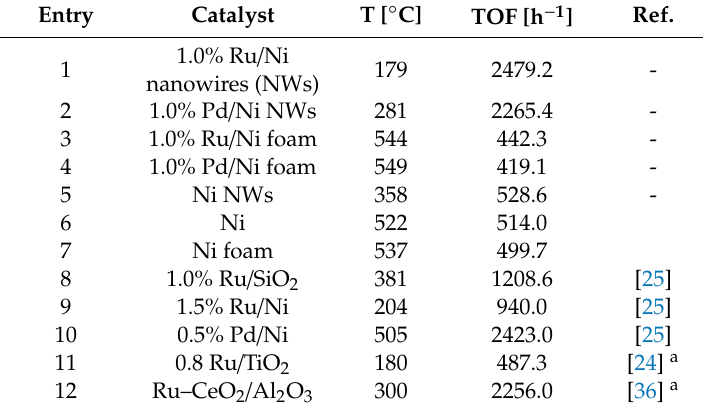
Table 3. CO 2 methanation on the Ru and Pd nanoparticles deposited on di ff erent nickel and silica carriers compared to the literature